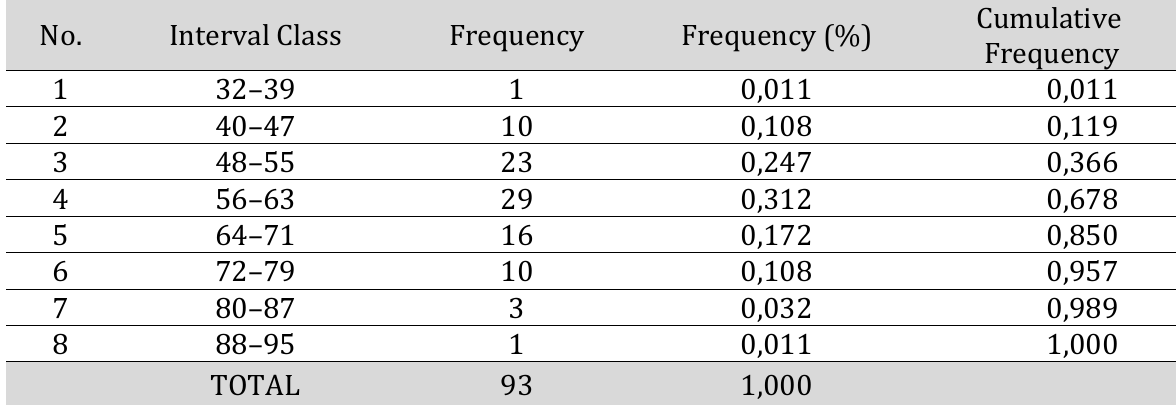
Table 12. frequency distribution of the scores of the students' writing motivation